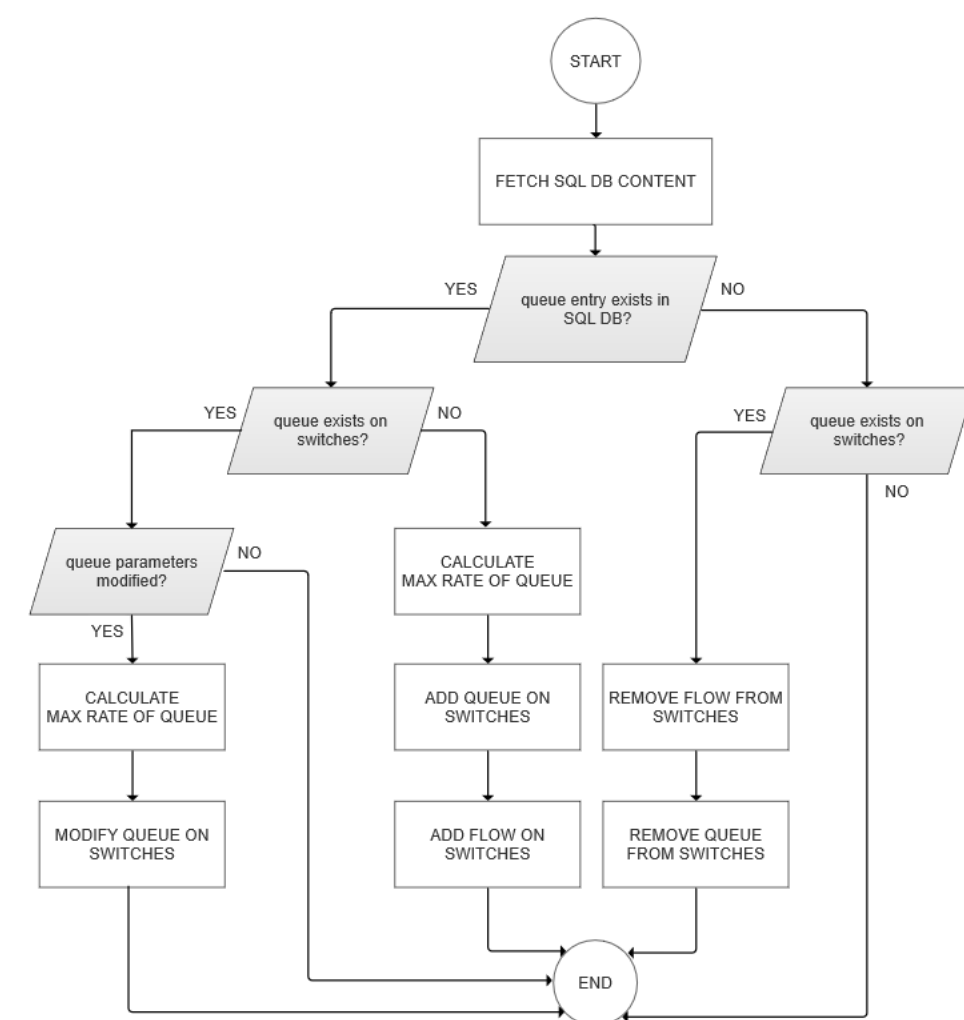
Figure 6. Process diagram of dynamic QoS